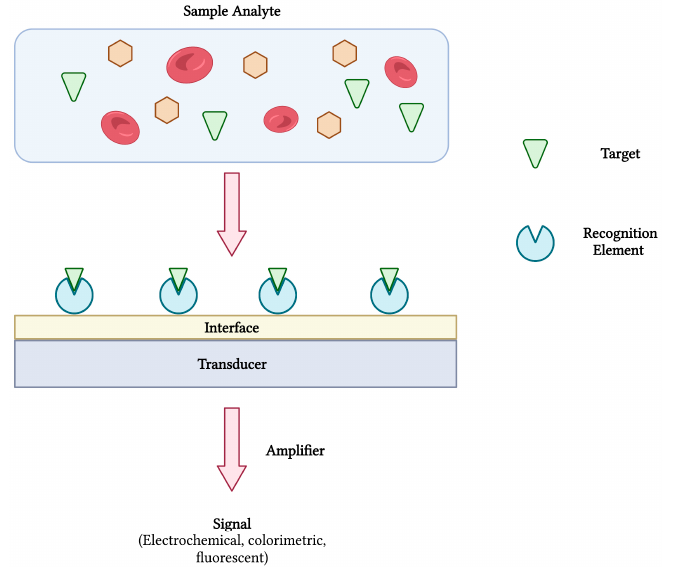
Figure 1. The schematic diagram of a biosensor and its components. The interaction between target analyte and recognition element is converted and amplified into a measurable signal. Adapted with permission from [17]. Created with BioRender.com (accessed on 19 December 2021).